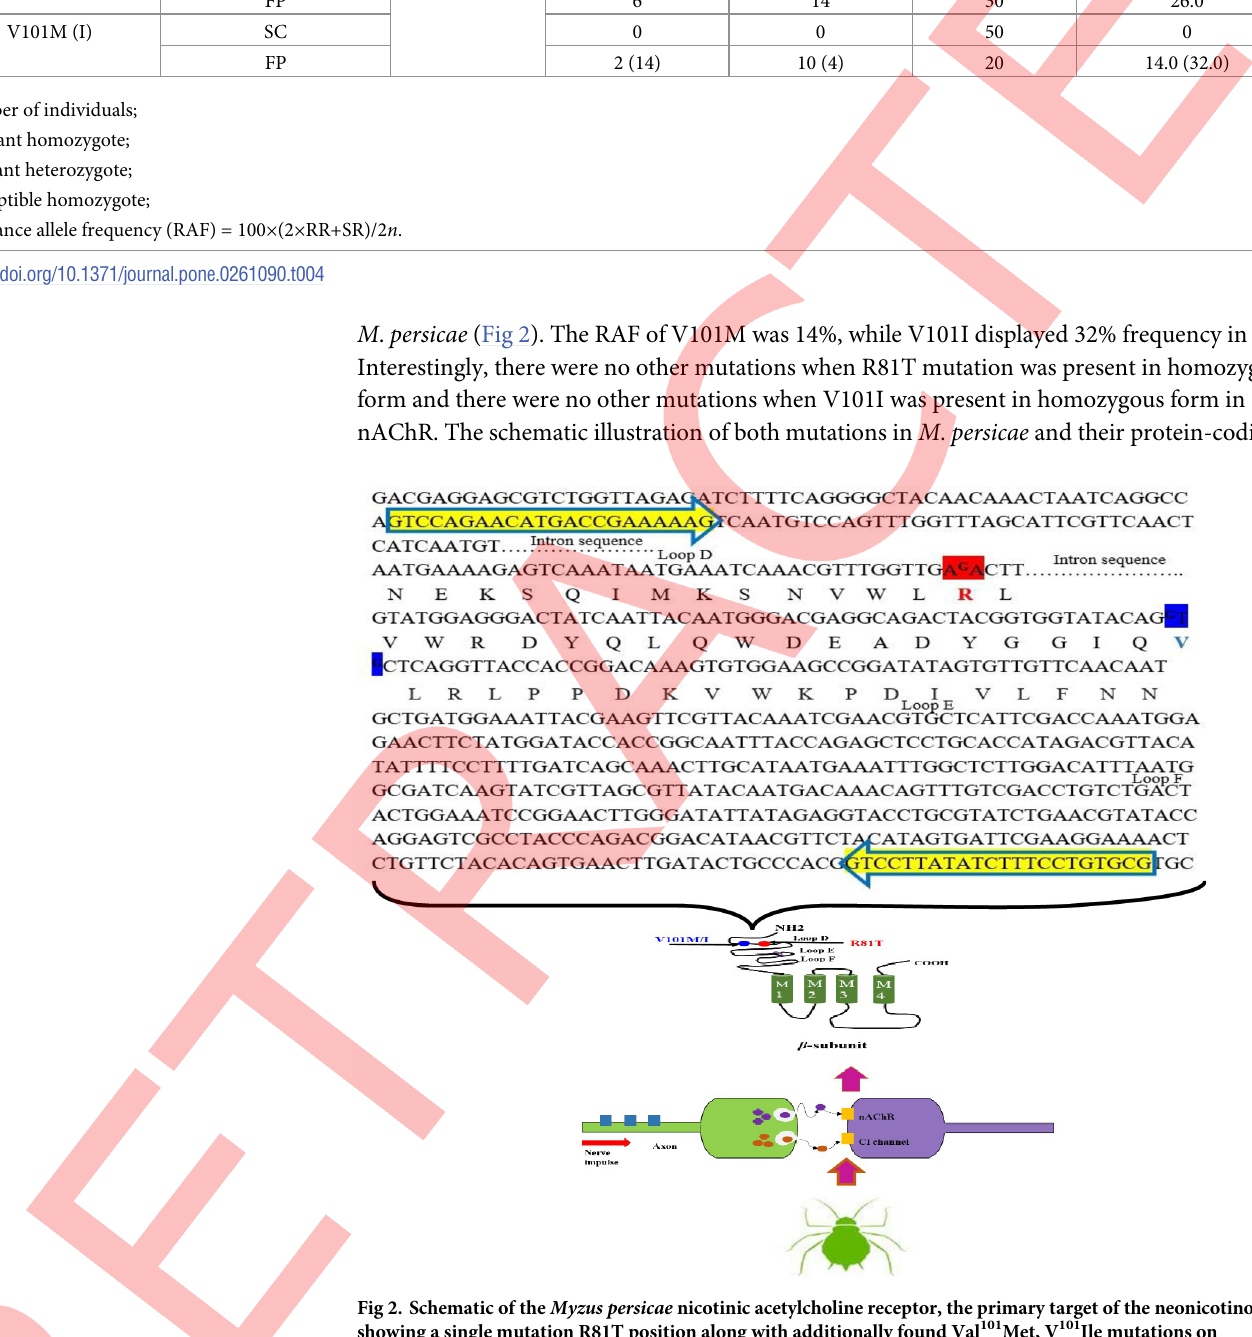
Fig 2. Schematic of the Myzus persicae nicotinic acetylcholine receptor, the primary target of the neonicotinoids, showing a single mutation R81T position along with additionally found Val 101 Met, V 101 Ile mutations on β -subunit at loop D. Coding domain of loop D nAChR of R81 (45 bp) and V101 (110 bp) mutation is presented as A G A– > A C A and G TG– > A TG / G T G – > A T A , respectively. Acetylcholine binding loop E and F are also presented on the protein-coding domain. Reproduced from [8,